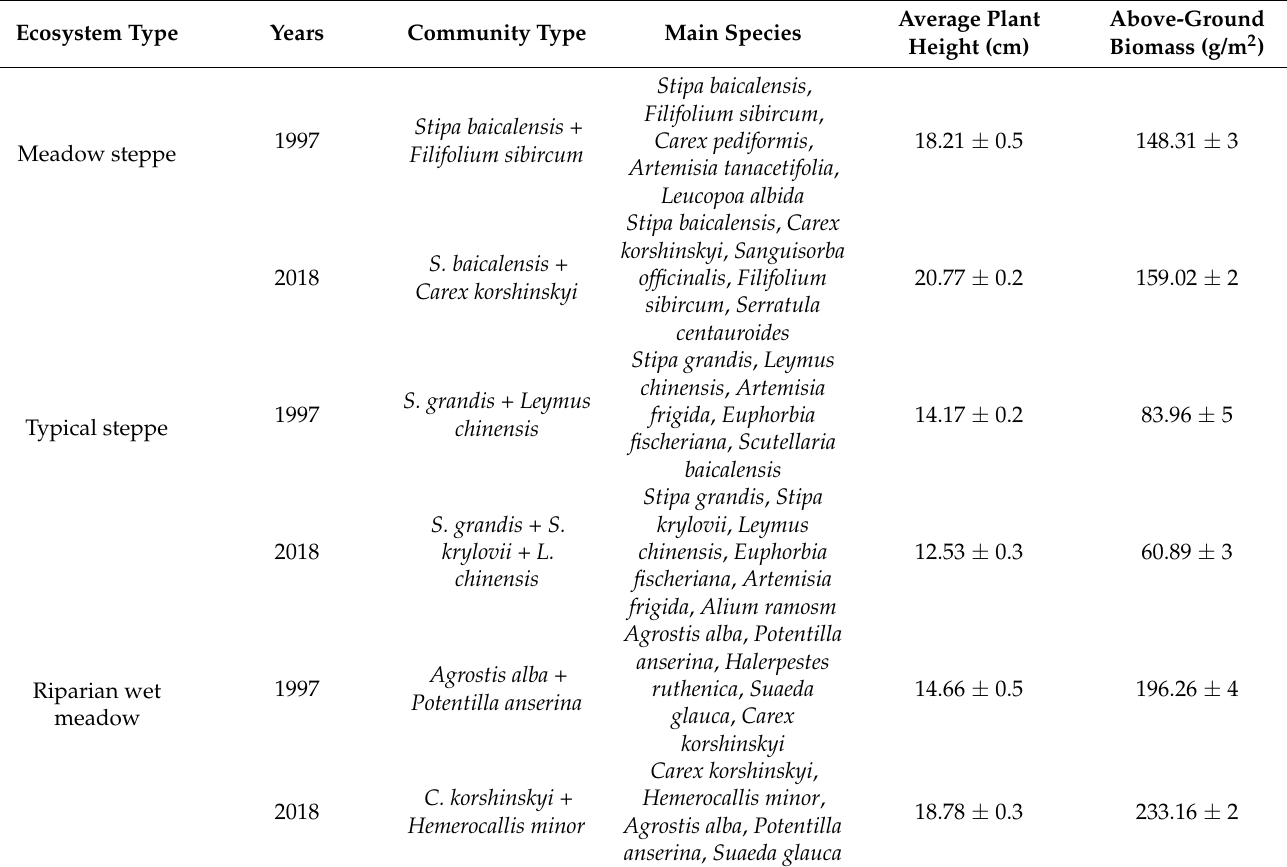
Table 4. Species composition of three